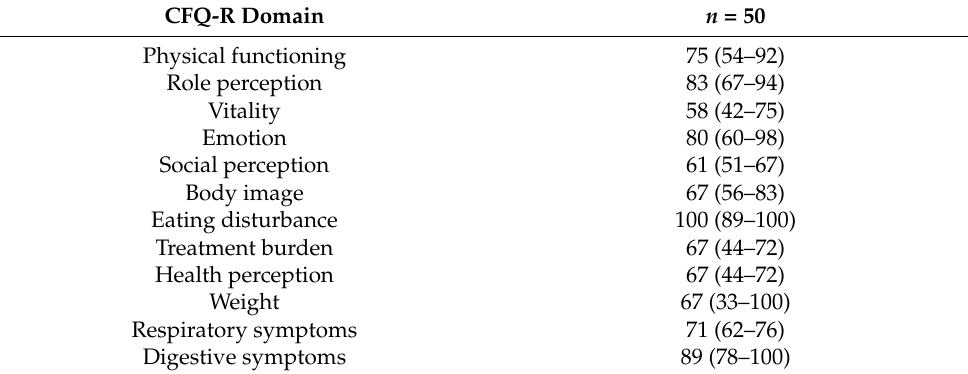
Table 3. Quality of life scale according to the